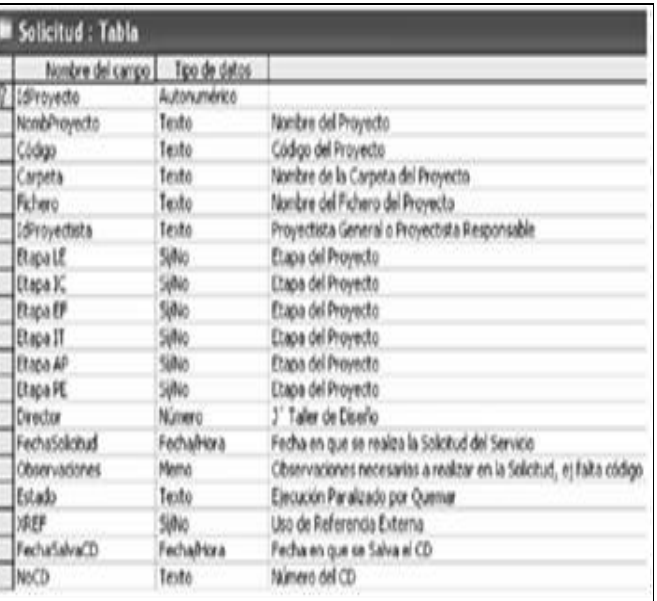
Figura 2: Ejemplo de Tabla de Solicitud. Fuente: Autor, (2018).